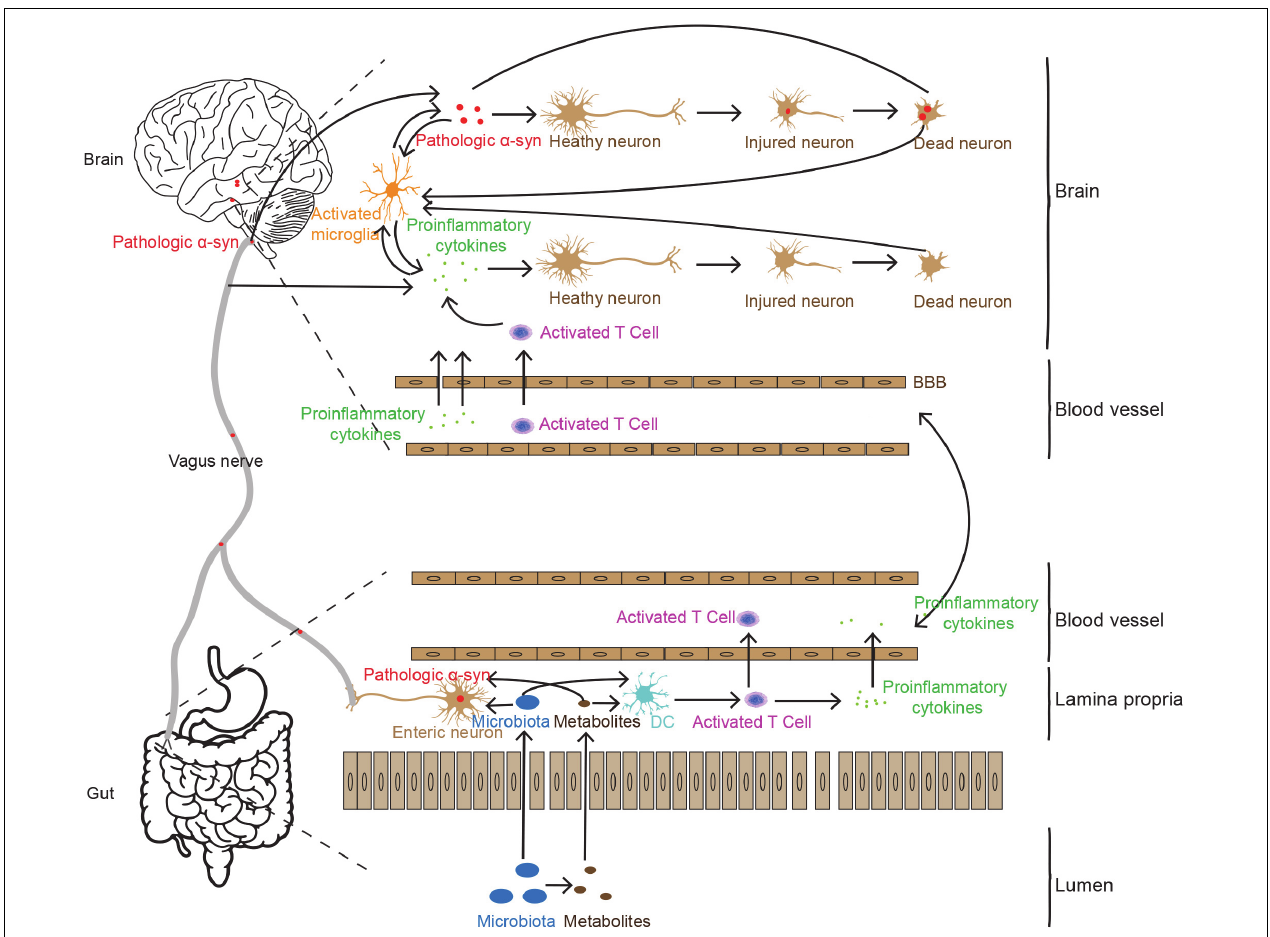
FIGURE 1 | Possible pathways involved in gut inflammation induced neuron death in the brain. Gut inflammation may increase intestinal permeability, allowing the leakage of bacteria and their metabolites which may trigger pathologic α -syn aggregation and pro-inflammatory cytokine production and release in the ENS. Pathologic α -syn is propagated to the brain via the vagal nerve, and inflammatory cytokines are transported to the brain through the humoral pathway or stimulate the vagal nerve to produce pro-inflammatory factors in the brain. Pro-inflammatory cytokines and synucleinopathies in the brain may induce neuronal injury and death, which in turn enhance more severe inflammatory